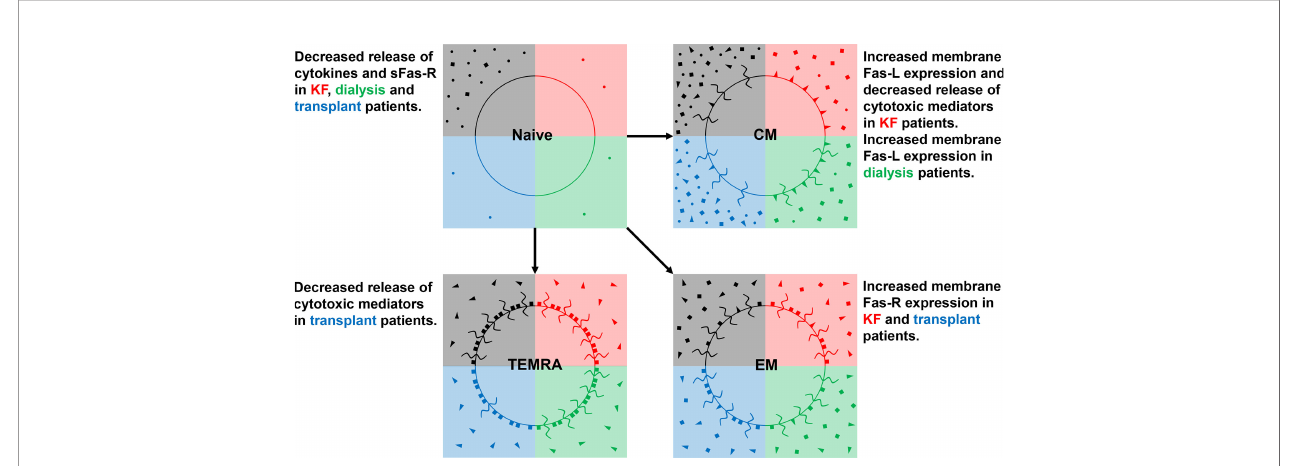
FIGURE 8 | Differences in the release of cytokines (IL-2, TNF- a , and IFN- g ) ( (cid:129) ), Fas-R ( ■ ), Fas-L ( ◄ ), and of cytotoxic mediators (granzyme A, perforin, and granulysin) ( ) between healthy controls (black quarter), KF patients (red quarter), dialysis patients (green quarter), and kidney transplant patients (blue quarter) in CD8 + naïve, CM, EM, and TEMRA